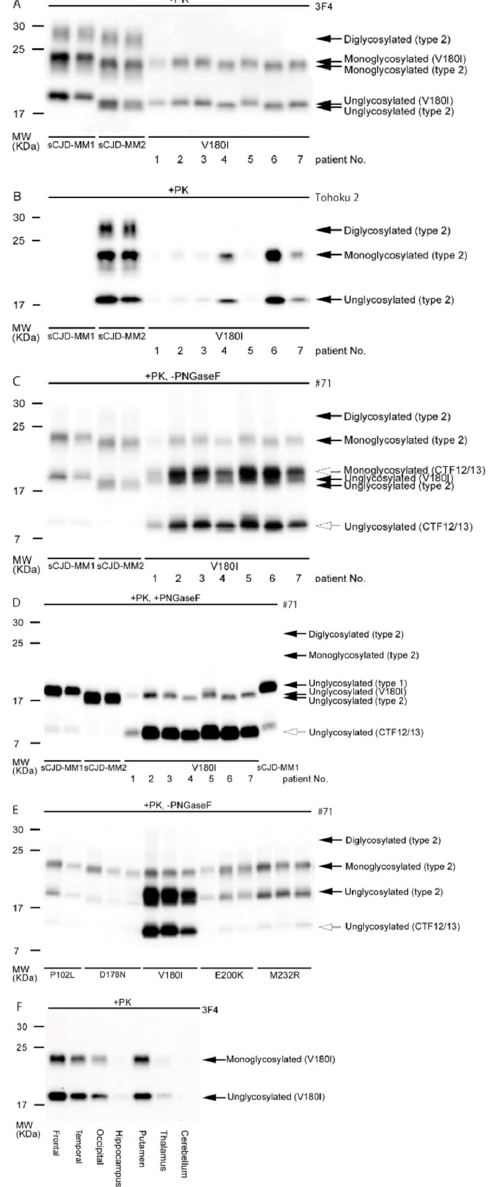
monoglycosylated CTF12/13 form (Figure 2C,D). Three components of the PrP Sc -V180I fragment complex and major PrP Sc fragments (types 1 and 2) were also shown as a diagram (Figure 3). Furthermore, the amount of unglycosylated CTF12/13 in patients with V180I- gCJD was higher than that in patients with other gPrDs (Figure 2E).